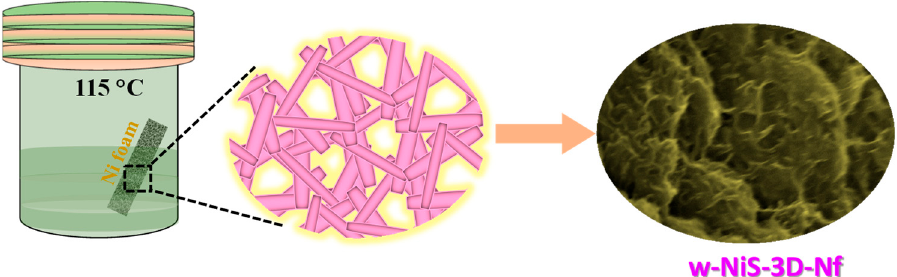
Figure 1. Schematic presentation of the preparation of the w-NiS-3D-Nf and NiS-3D-Nf electrode.